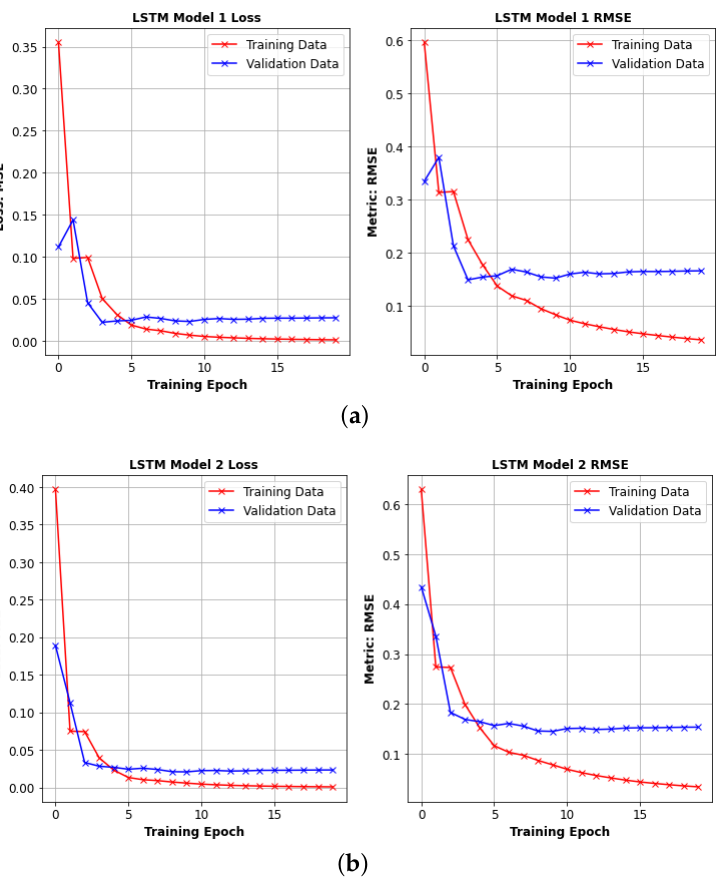
Figure 12. Learning curve for LSTM networks Model 1 and Model 2. ( a ) LSTM Model 1. ( b ) LSTM Model 2.